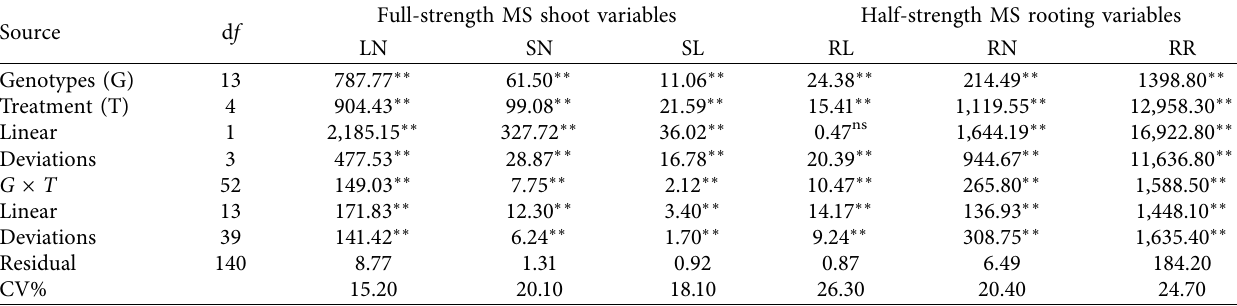
Table 1: Mean square values of shooting and rooting variables from cotyledon